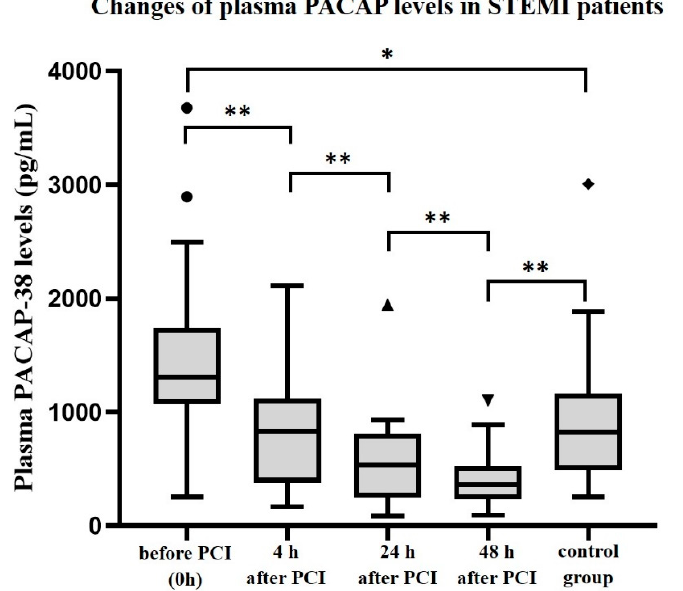
Figure 5. Changes of plasma PACAP levels in STEMI patient after PCI and in healthy control group. The solid bars represent medians of 16 patients and 12 controls. The boxes show the interquartile ranges, and the whiskers indicate the 10th and 90th percentile, outliers are also plotted with dots, rhombus and triangles. The middle line within the boxes represents the mean values. Wilcoxon Rank-Sum Test was used, statistically significant differences with p -values of ** < 0.001 and * < 0.05 are indicated.